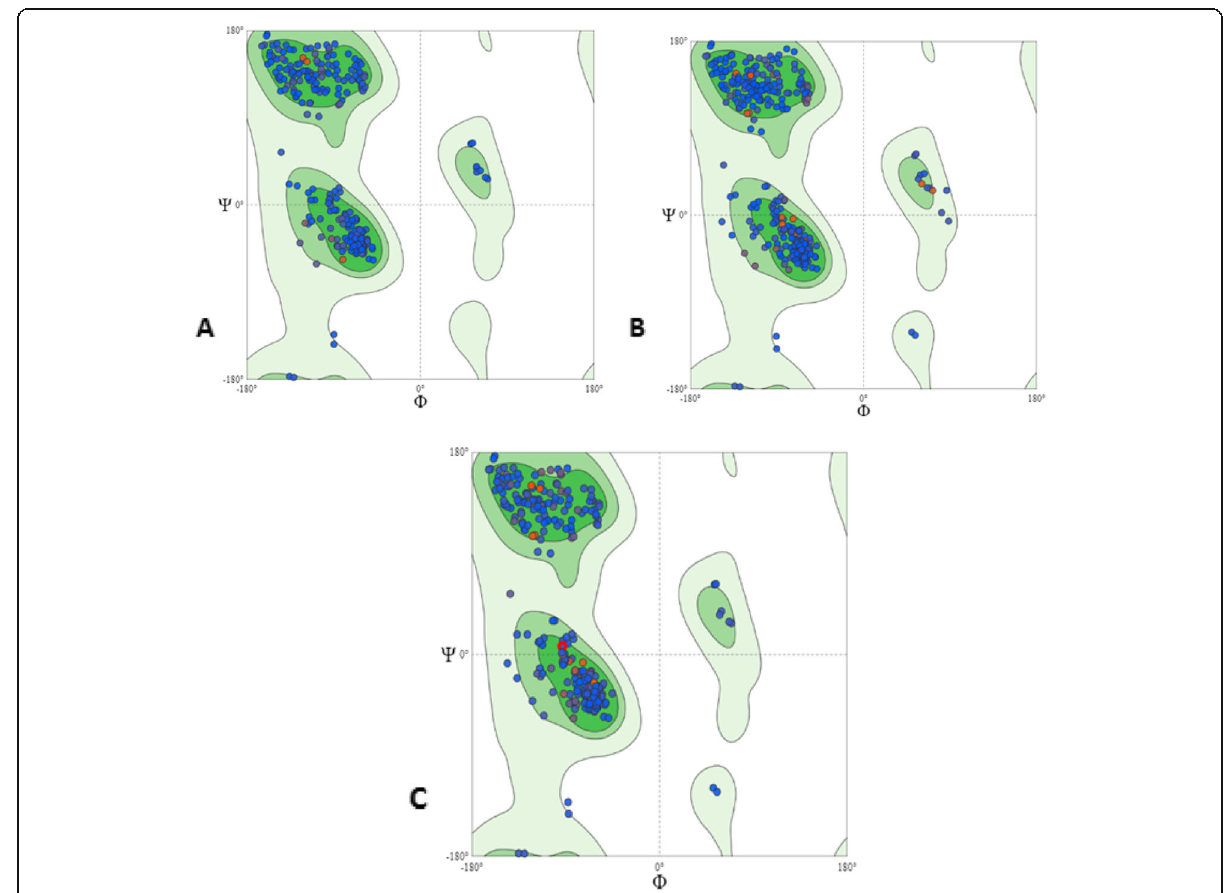
Fig. 5 The stereochemical validation of the hypothetical model using Ramachandran plot of a CURS1, b CURS2, and c CURS3